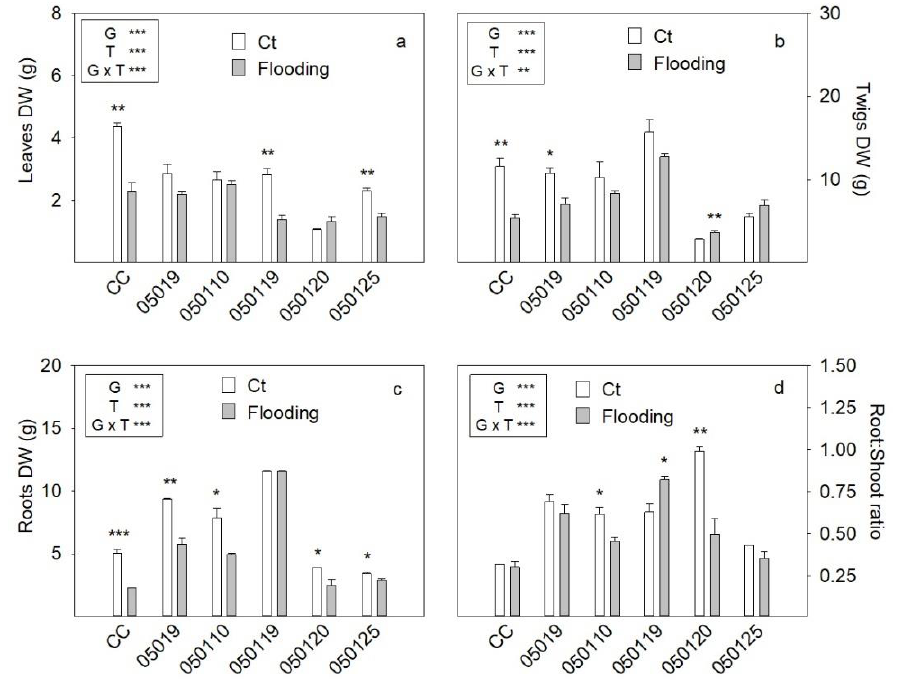
Figure 1. Dry weight (DW) in ( a ) leaves, ( b ) twigs, and ( c ) roots, and ( d ) the root – shoot ratio of five citrus hybrids grown for 35 days in the non-stressed (Ct) or flooding treatment. Values are the means of six independent seedlings ( n = 6). In each hybrid, comparisons among treatments were made by Fisher’s least significance difference (LSD) test. * p < 0.05, ** p < 0.01, *** p < 0.001. CC: Carrizo citrange; G: genotype, T: